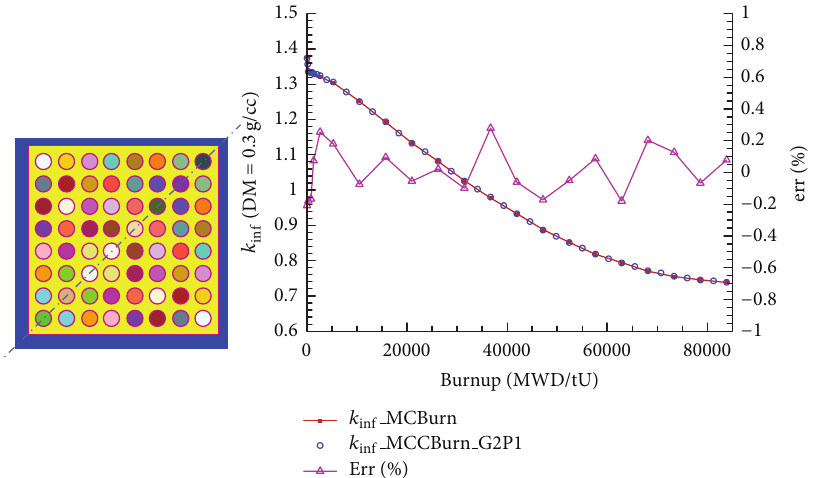
Figure 4: A BWR assembly model and its burnup calculation results.